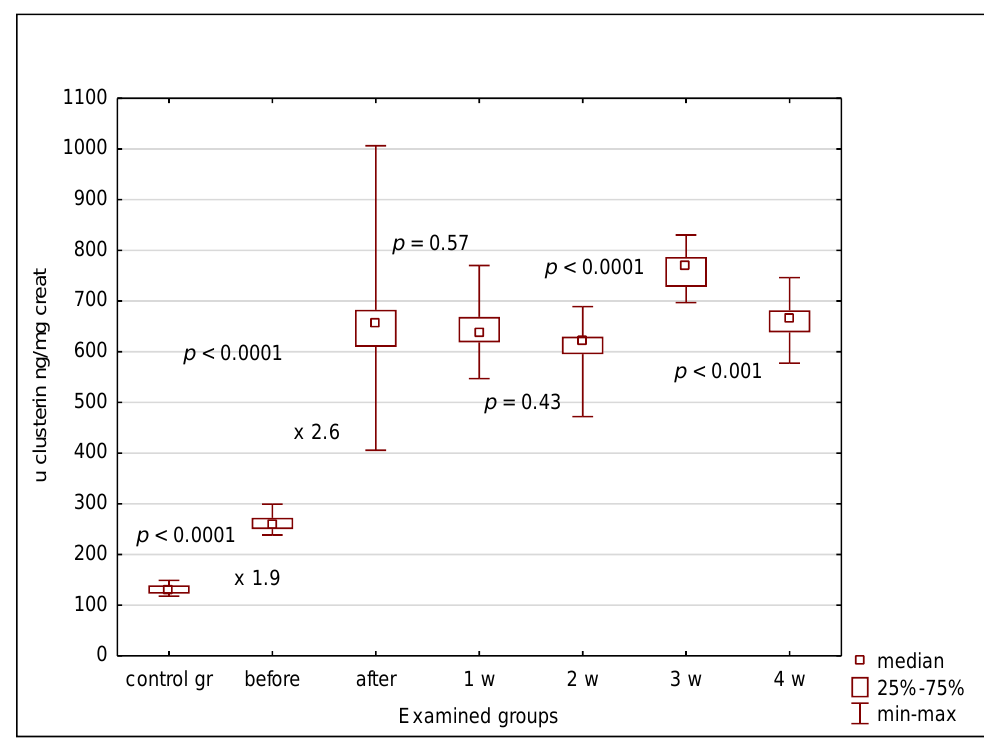
Figure 2. Urinary clusterin values in examined groups. before—before alloHSCT; after—24 h after alloHSCT; 1 w (2 w, 3 w, 4 w)—1 week (2, 3, 4 weeks) after alloHSCT. J. Clin. Med. 2020 , 9 , x FOR PEER REVIEW